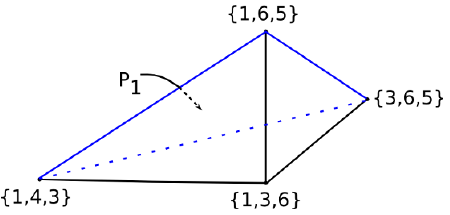
Figure 7 . A depiction of the newly de(cid:12)ned plane when triangulating the three-polytope P 2 without introducing spurious